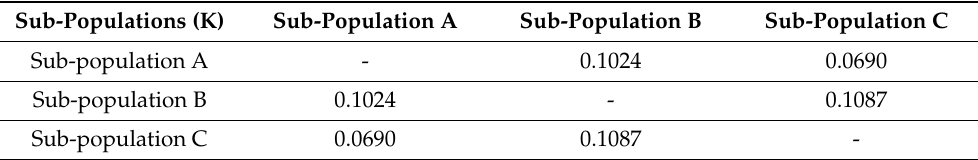
Table 7. Genetic differentiation based on Fst values among forage pea ( P. sativum ssp. arvense L.) landrace accession sub-populations identified by population structure